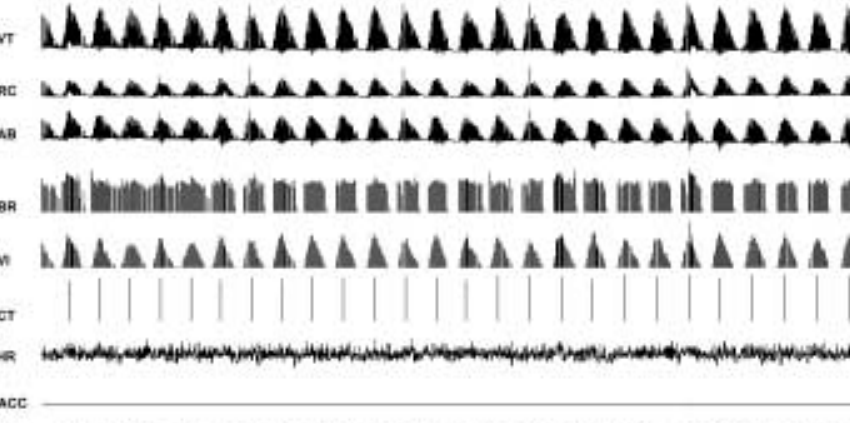
Diurnal and nocturnal prevalence of Cheyne- Stokes respiration in patients with severe CHF (left ventricular ejection fraction <35%). The white area represents patients with less than 5 cycles of CSR/h, the light grey area indicates patients with 5–15 cycles of CSR/h and the dark grey area signifies patients with more than 15 cycles of CSR/h. At a cut-off level of 15 cycles of CSR/h, the diurnal and the nocturnal preva- lence of CSR was 28% and 71%, respectively